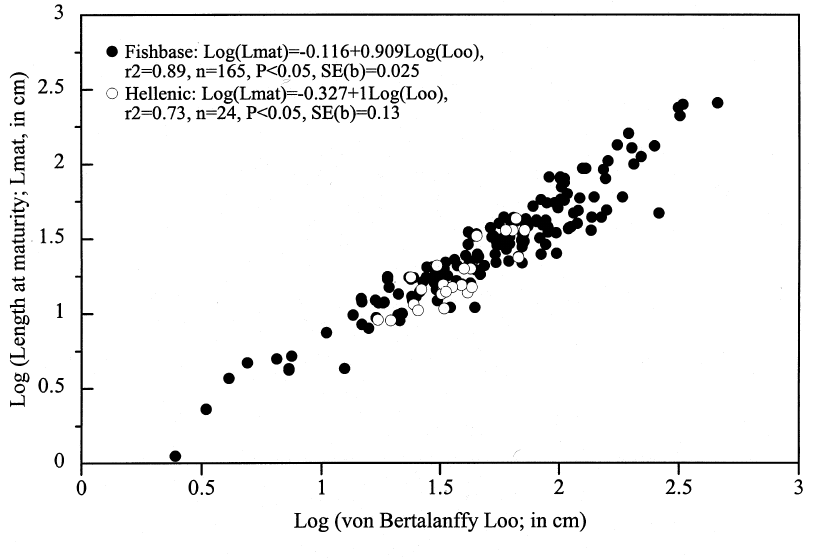
Fig. 6. Relationship be- tween the female length- at-maturity and the von parameter Bertalanffy L oo for a variety of fish stocks in Hellenic waters (open circles) and for 165 stocks registered in FishBase 98 (black circles; data from the Maturity table: Binohlan 1998). The two slopes do not differ signif- icantly (ANCOVA,